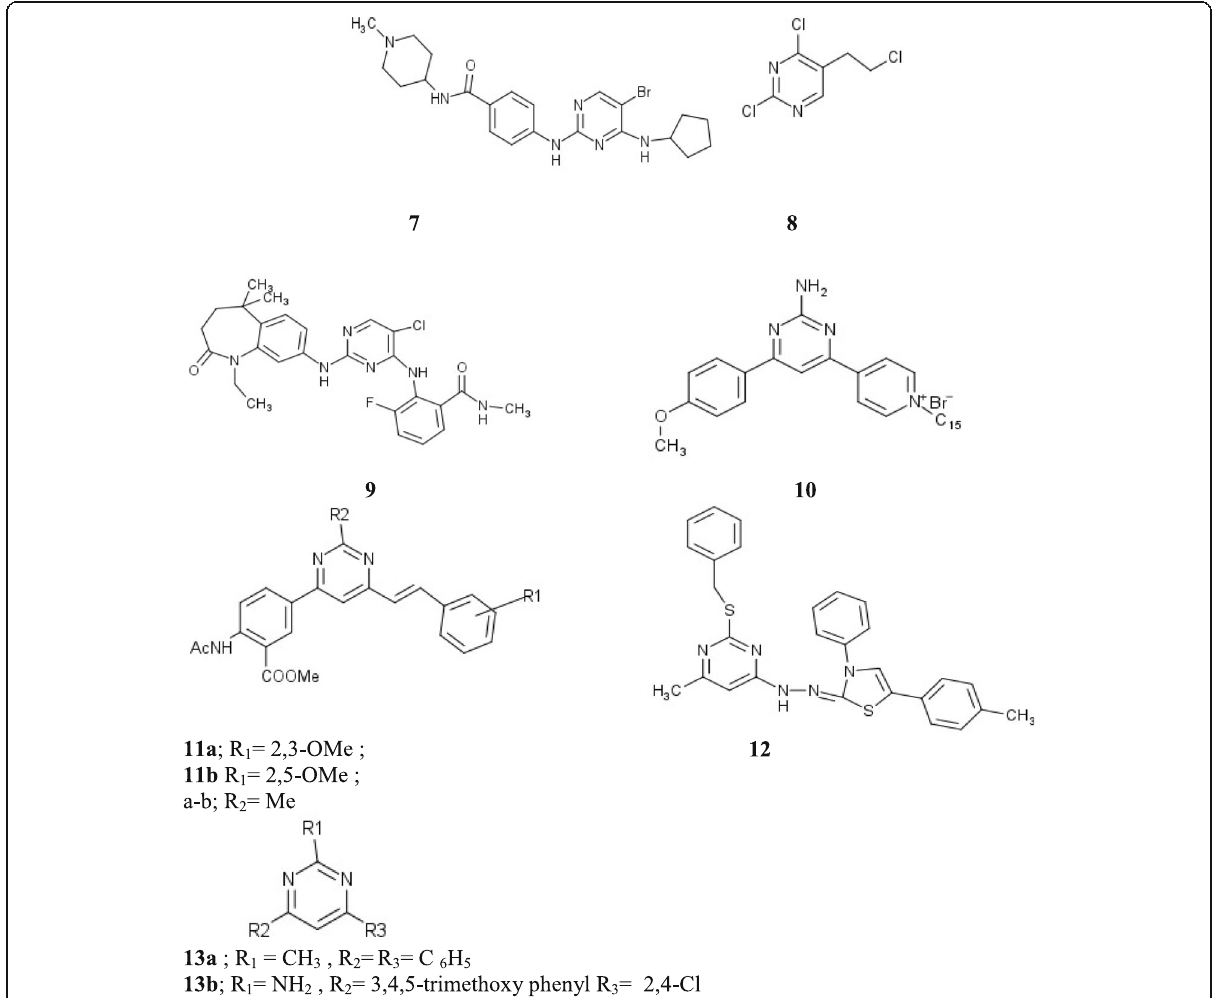
Fig. 4 Chemical structures of trisubstituted pyrimidine derivatives